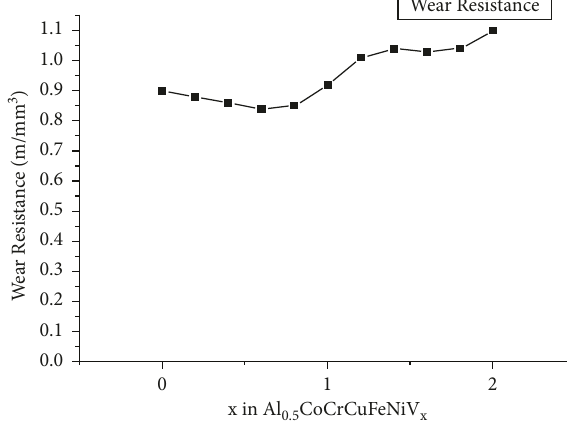
Figure 21: Wear resistance of Al 0.5 CoCrCuFeNiV x HEA with different vanadium contents